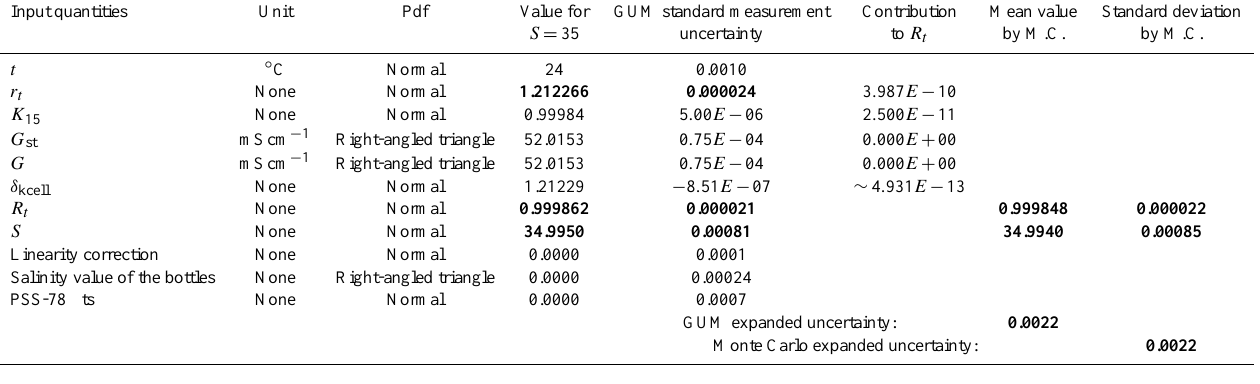
Table 1. Parameters of the input quantities used to compute the expanded uncertainty of Guildline Portasal salinometer for S = 35, by the GUM and the Monte Carlo (M.C.) methods.